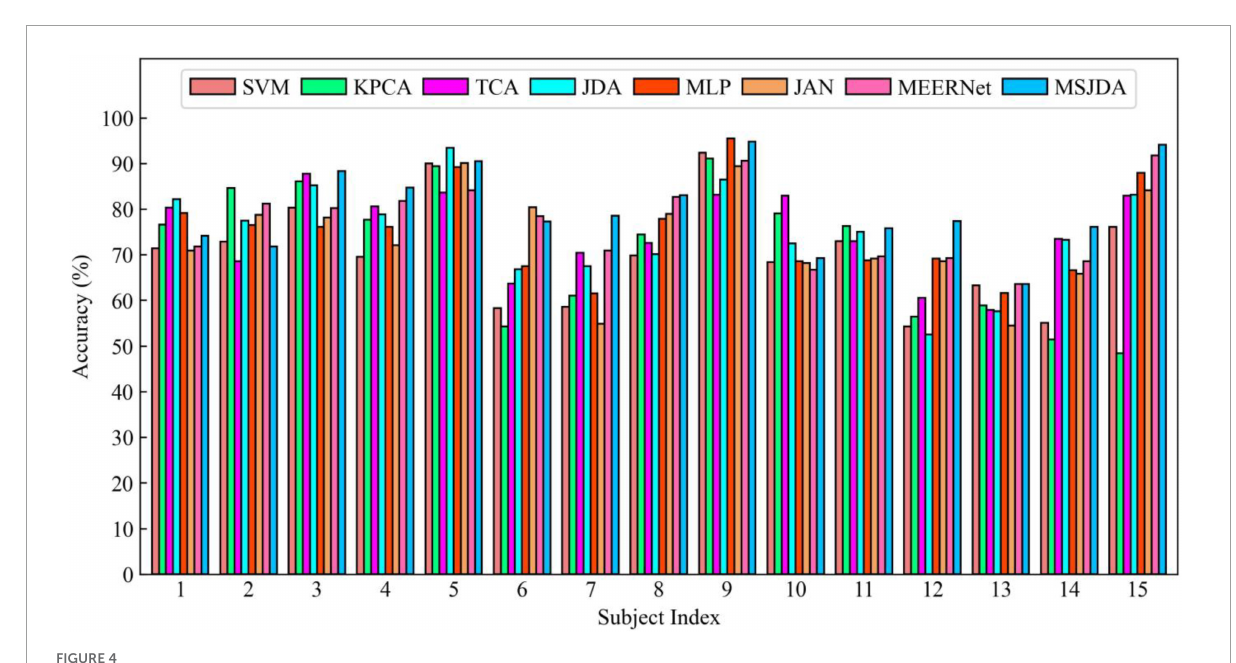
FIGURE4 Results of cross-subject experiments in the second